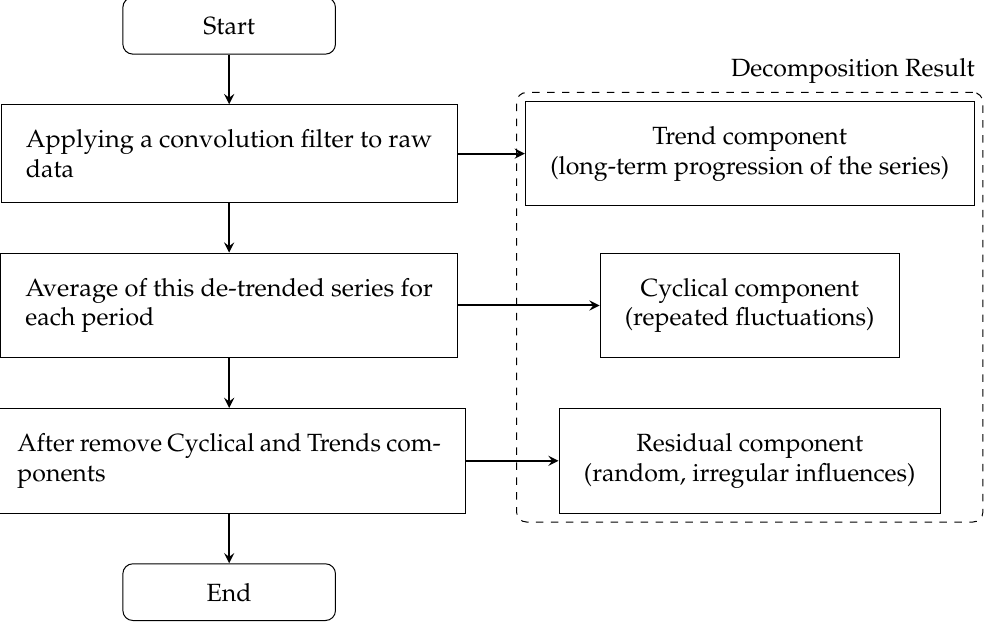
Figure 7. Time series decomposition flow